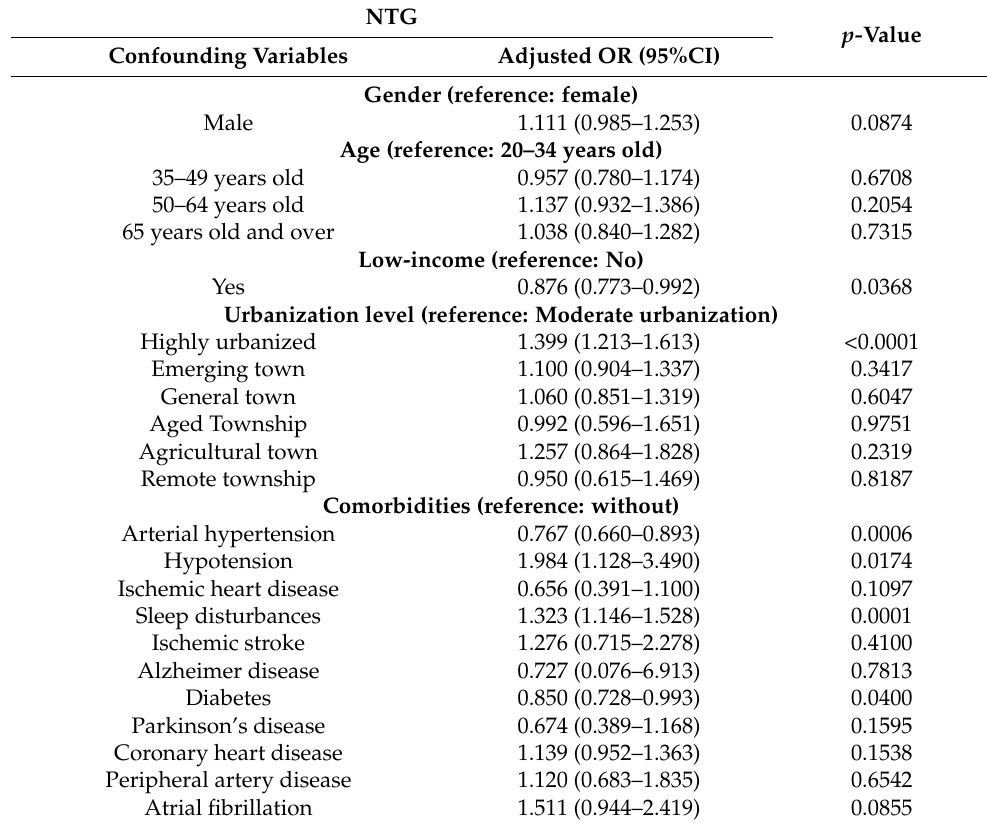
Table 2. Logic regression analysis of NTG and